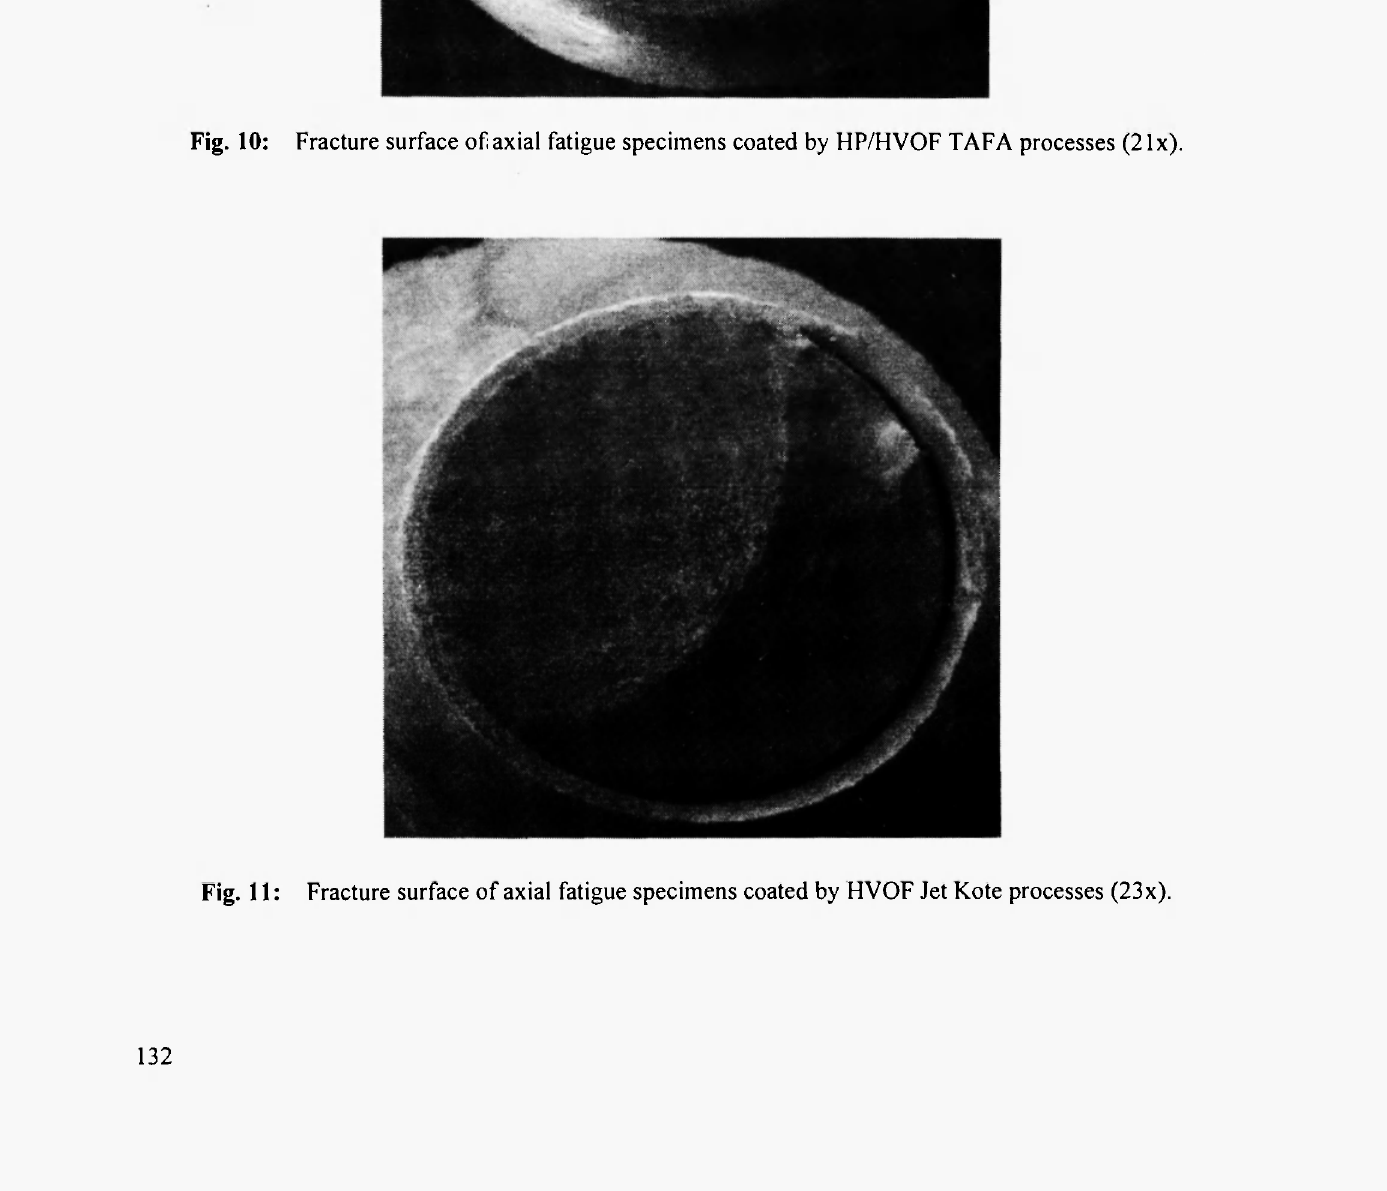
Fig. 11: Fracture surface of axial fatigue specimens coated by HVOF Jet Kote processes